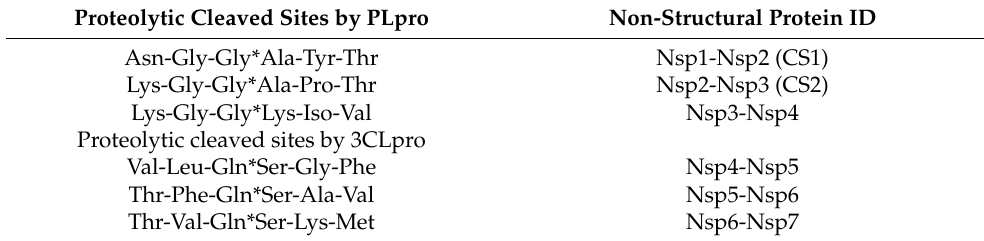
Table 1. List of non-structural proteins cleaved by PLpro and 3CLpro, respectively, with * marking the cleavage